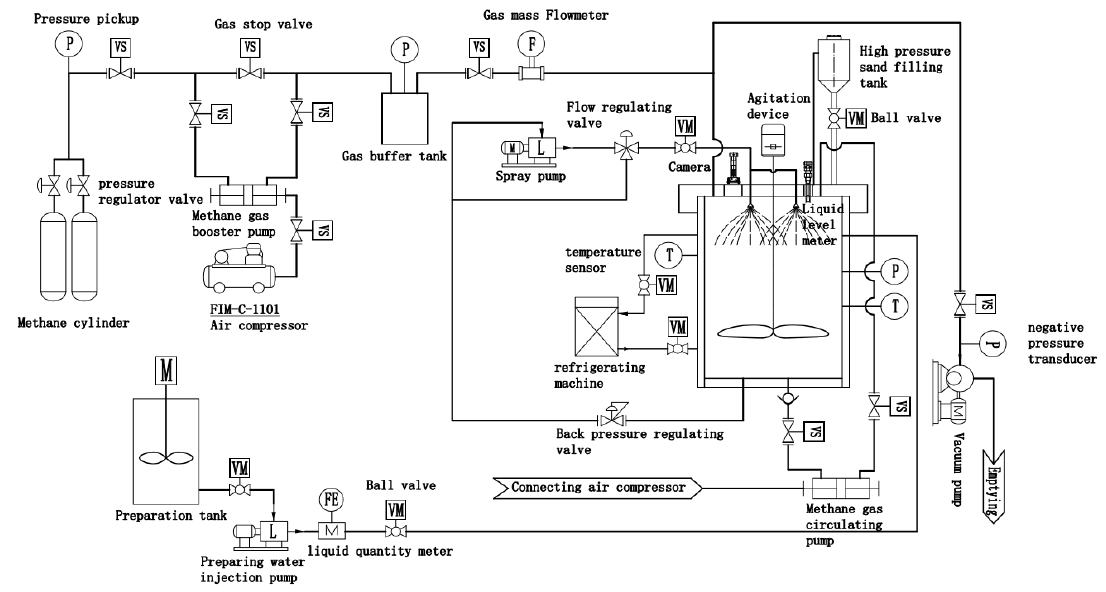
Figure 1. The flow chart of rapid preparation of non-diagenetic natural gas hydrate in three-in-one method.